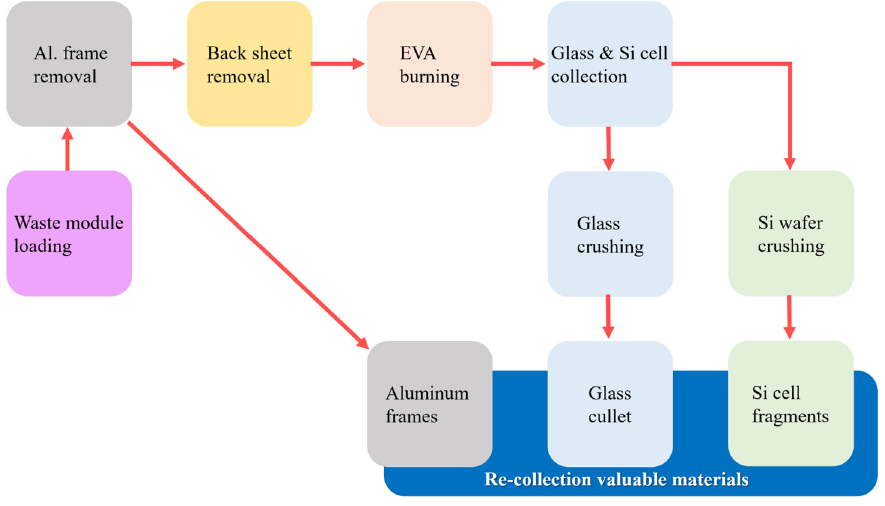
Figure 1. Foundation for Advancement of International Science (FAIS) PV panel recycling